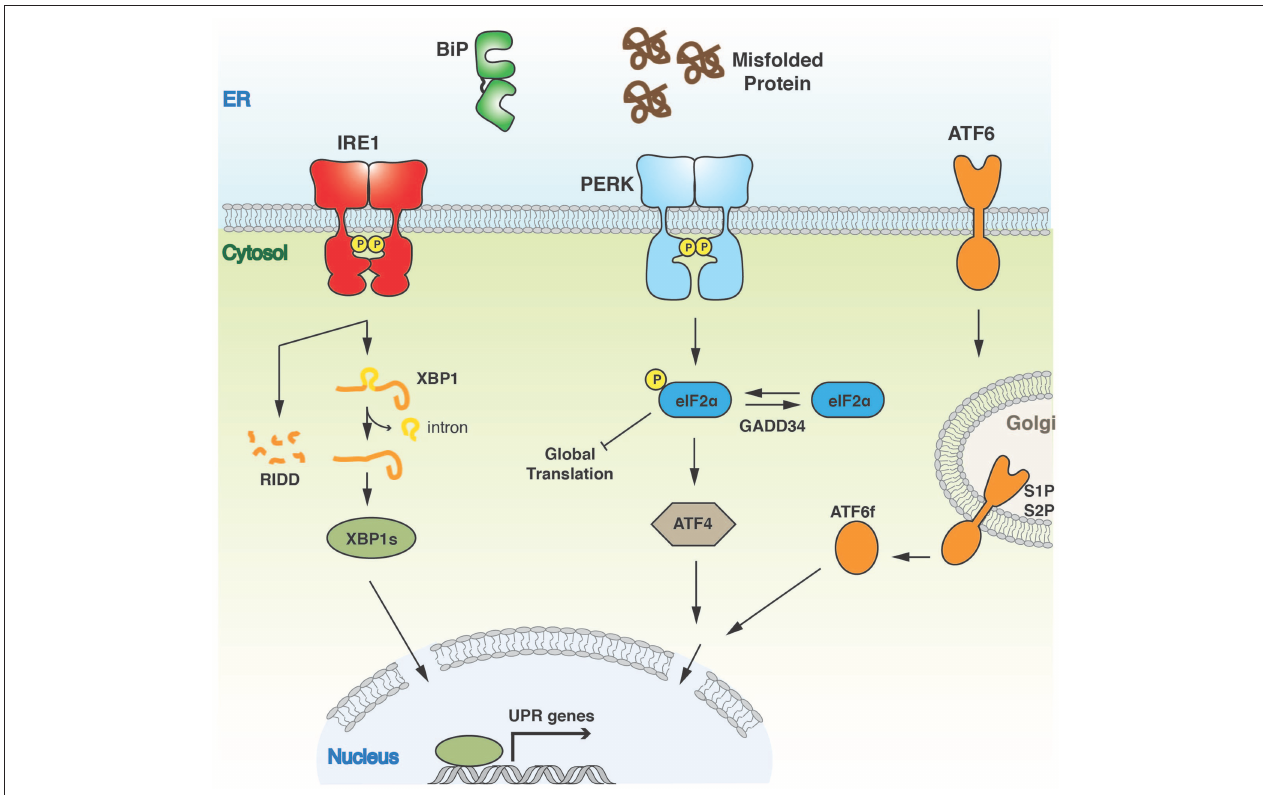
FIGURE 1 | Overview of UPR signaling pathway. The UPR instigates a transcriptional and translational response to ER stress. The three UPR activator proteins, IRE1, PERK, and ATF6 give rise to three separate branches of the response, all of which aim to alleviate the burden of misfolded protein and to ensure successful ER protein